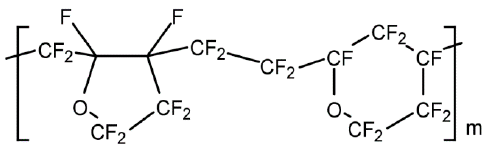
Figure 2. Chemical structure of the cyclic perfluoropolymer, Cytop TM .